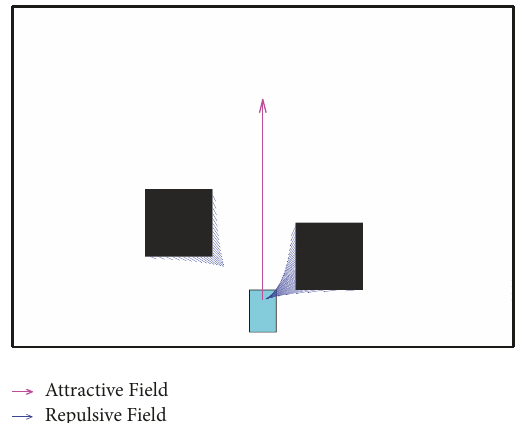
Figure 2: Attractive field and repulsive field in PFM.